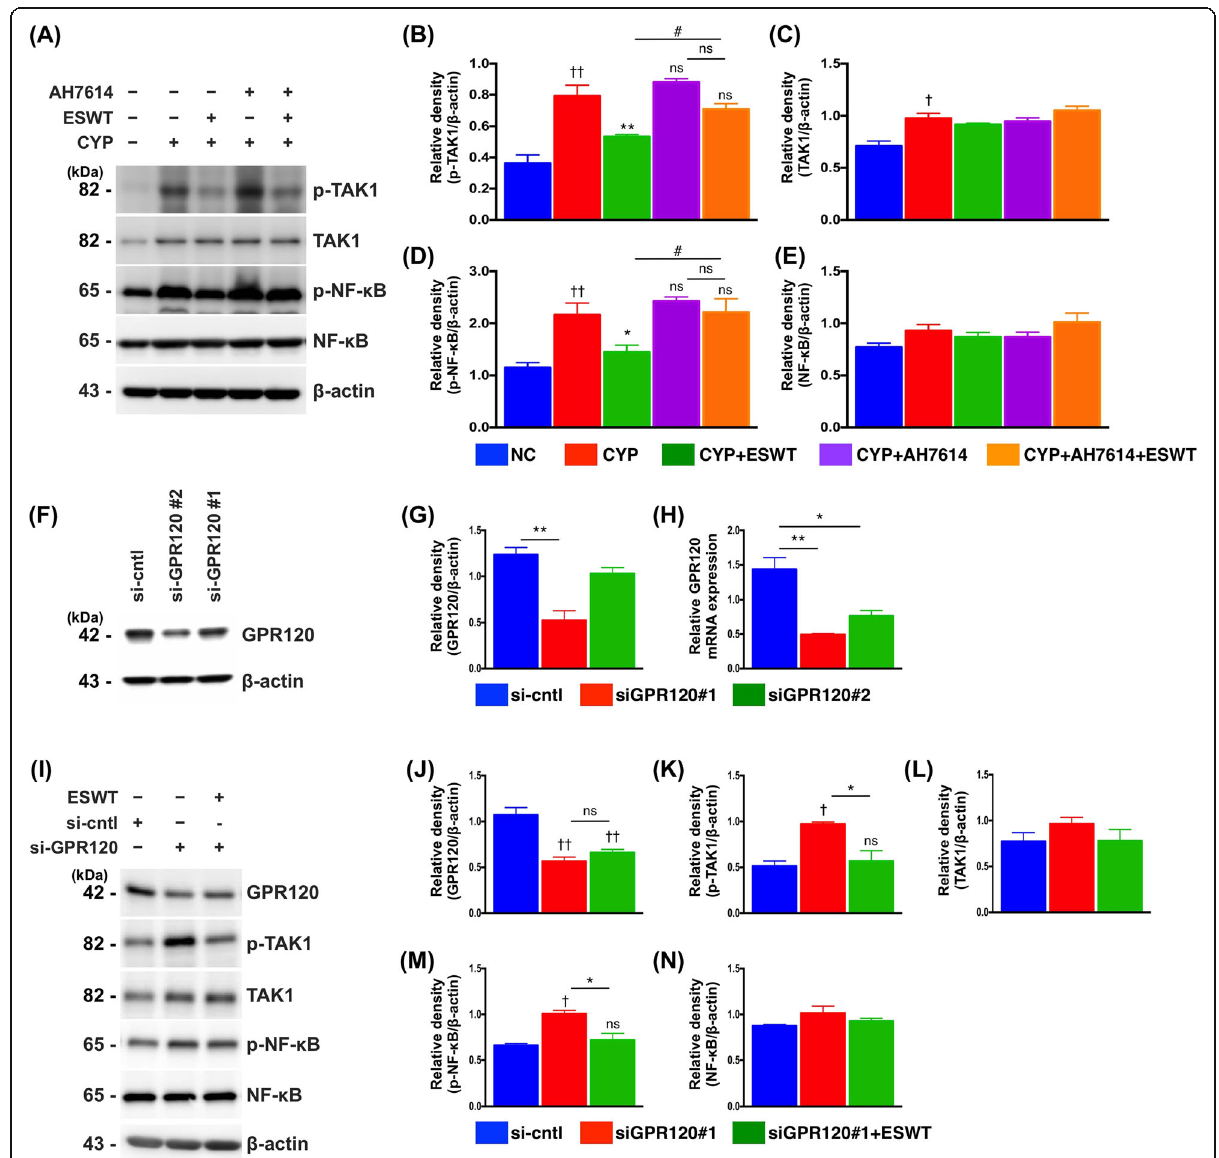
Fig. 3 Effect of extracorporeal shock wave treatment (ESWT) and GPR120 antagonist on cyclophosphamide (CYP)-stimulated inflammatory response in urothelial RT4 cells. a-e Protein expressions of active pro-inflammatory markers (i.e., p-TAK1 and p-NF- κ B) in CYP-stimulated RT4 cells at 4 h with and without prior treatment with GPR120 antagonist (i.e., AH7614) compared to those induced through ESWT. f-h Immunoblotting of RT4 cells treated with GPR120-specific or control (si-cntl) siRNA for 48 h showing that exposure to GPR120-specific siRNA reduced endogenous GPR120 mRNA and protein expression by approximately 50%. i-n Knockdown of GPR120 significantly impaired the ability of ESWT to reduce p- TAK1 and p-NF- κ B. β -actin used as internal control for immunoblotting. Values expressed as the mean ± SD of three independent experiments. * p < 0.05, ** p < 0.01 vs. CYP/siGPR120; † p < 0.05, †† p < 0.01 vs. control; # p < 0.05, vs. CYP + ESWT; ns, non-significance. Significance of